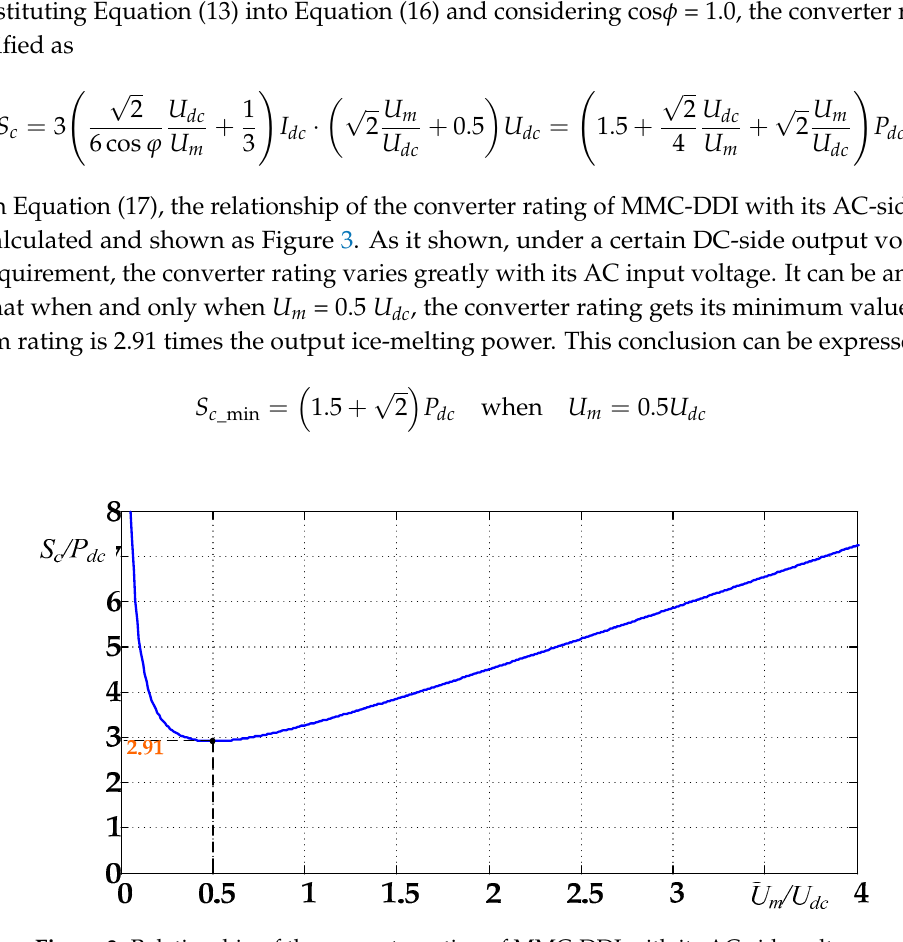
Figure 3. Relationship of the converter rating of MMC-DDI with its AC-side voltage.